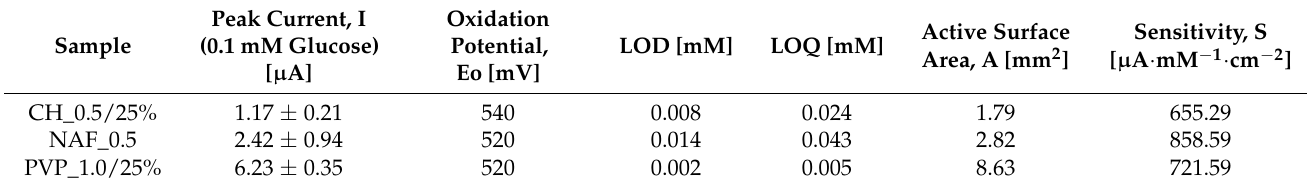
Table 3. Summary of electrodes electrochemical